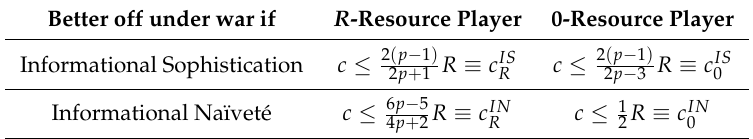
Table 1. Threshold of c below which a player expects to be better off under war than peace. Better off under war